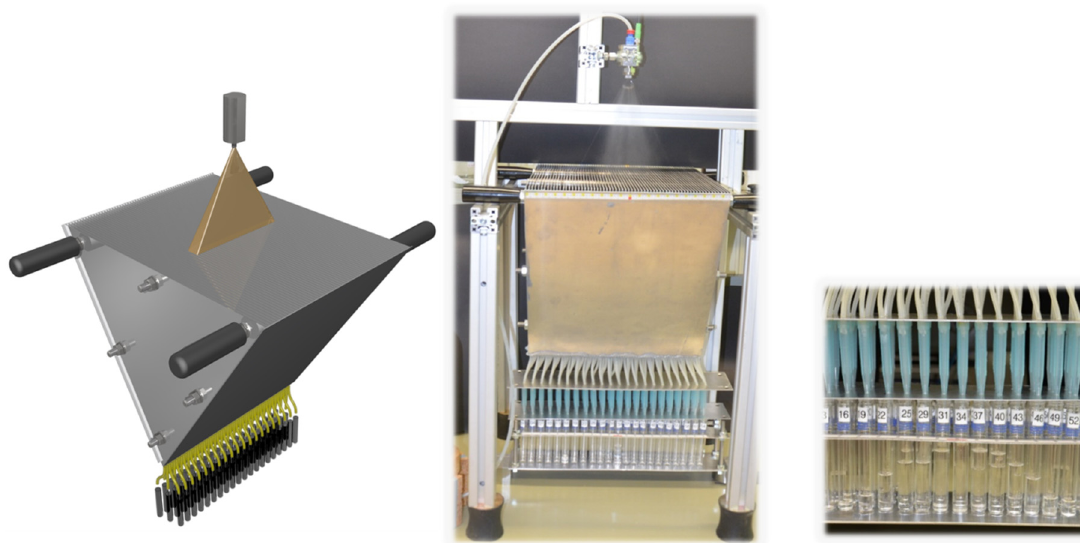
Figure 3. Schematic view ( left ) and image ( center , right ) of an in–house spray collector. Spray is collected in 66 chambers, each of 0.47 cm width; 31 cm in total. The spraying nozzle was fixed on an aluminium profile rack (Rose + Krieger GmbH; Minden, Germany) at a distance of 17.5 cm. Testing tubes were arranged in three rows.